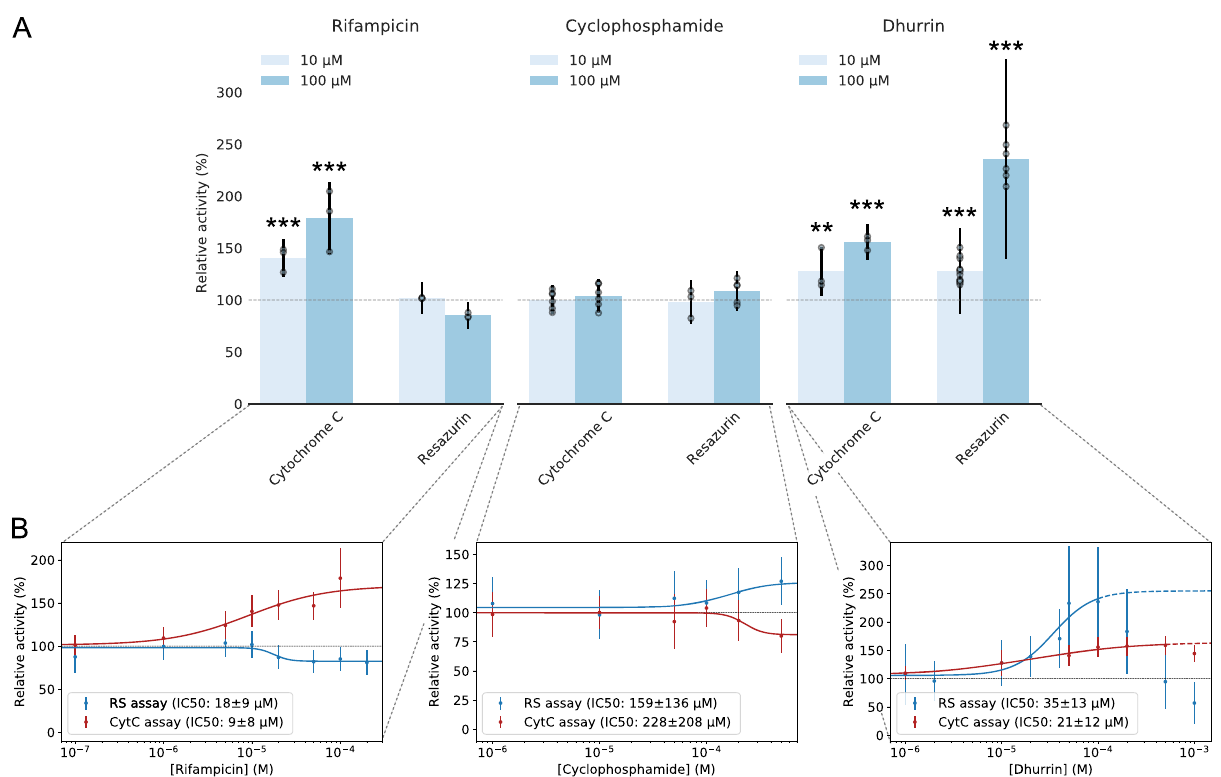
Fig. 3 Small-molecule ligands bias speci fi city of plant POR (SbPOR2b) to reduce diverse electron acceptors. A Effects of small-molecule ligands on SbPOR2b activity in proteoliposomes using Cyt c and RS as electron acceptors. B Dose-response curves of rifampicin, cyclophosphamide and dhurrin in the Cyt c and RS assays, respectively. Rifampicin acts as an agonist towards Cyt c enhancing its reduction rate and inverse agonist towards RS reducing the reduction rate. Cyclophosphamide displays the reverse effect acting as an inverse agonist towards Cyt c reduction and agonist towards RS reduction. Dhurrin acts as an agonist towards both Cyt c and RS reduction at low micromolar concentrations. The fact that ligands display differential effects on SbPOR2b activity to reduce the two electron acceptors indicates biased speci fi city of POR. IC50 values are extracted from the Hill equation. A , B The bar plots and dose-response curves represent the mean ± SD of independent replicates normalized to controls with propagated error ( n = 3 – 12; see Supplementary Fig. 9 for raw data and Supplementary Table 3 for exact value of n for each experimental condition). All data are corrected for potential ligand photophysical effect (see Supplementary Fig. 7). Note, overlapping data points appear shaded. Level of signi fi cance is determined by one-way ANOVA and Tukey ’ s HSD test correcting for multiple comparisons (* p < 0.05; ** p < 0.01; *** p < 0.005; see Supplementary Material for details). Source data are provided as a Source Data fi